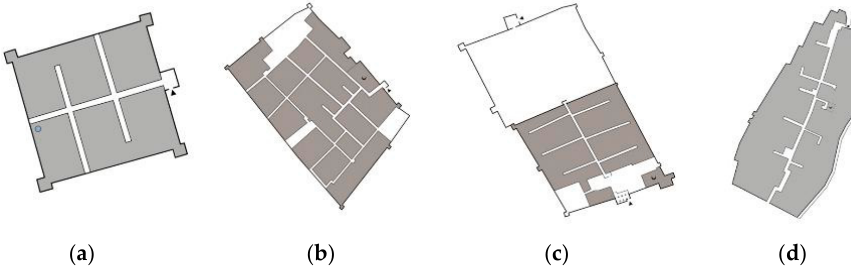
Figure 5. Ksour’s ground floor plans: ( a ) Al-Zaouiat (Outat Valley); ( b ) Asrir (Mdagra Oasis); ( c ) Beni M’Hali (Mdagra Oasis); ( d ) Ait Ouafella (Outat Valley).